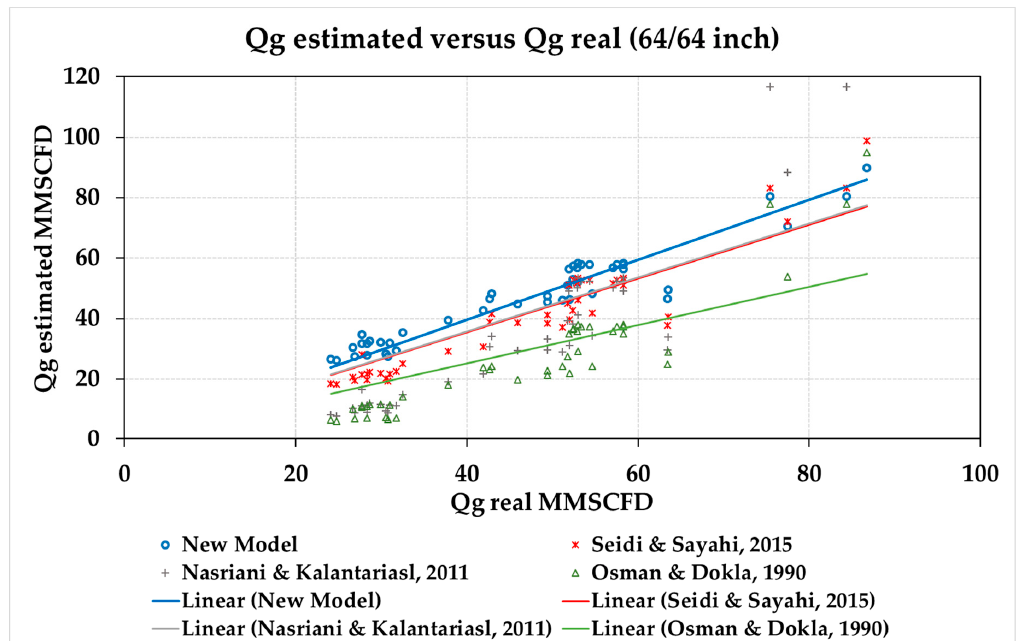
Figure 7 . Estimated gas flow rate versus real gas flow rate (64/64 inch) .